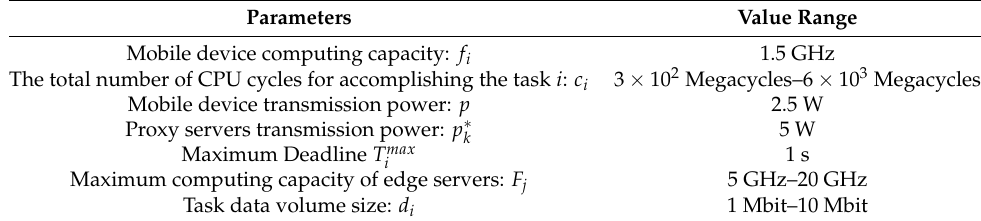
Table 1. Experimental parameters. Parameters Value Range Mobile device computing capacity: f i 1.5 GHz The total number of CPU cycles for accomplishing the task i : c i 3 × 10 2 Megacycles–6 × 10 3 Megacycles Mobile device transmission power: p 2.5 W Proxy servers transmission power: p ∗ k Maximum computing capacity of edge servers: F